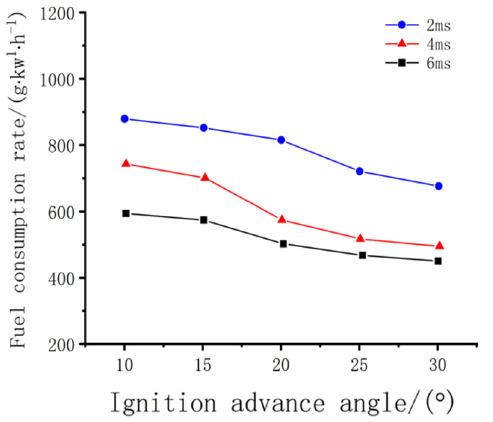
Figure 26. Effect of the ignition parameters on fuel consumption.